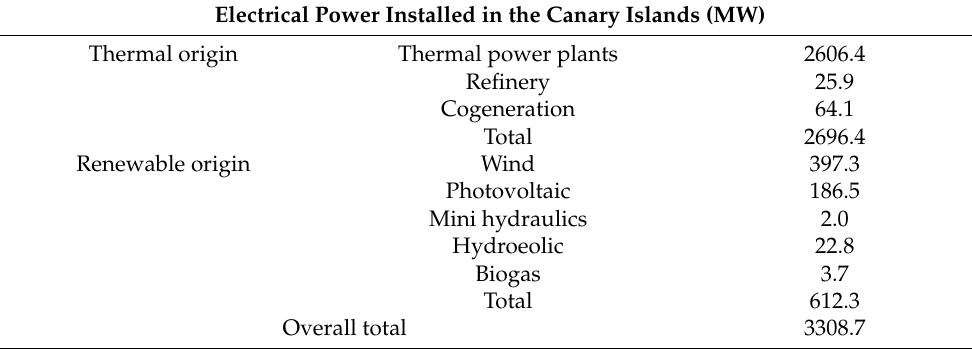
Table 4. Electrical power installed in the Canary Islands.